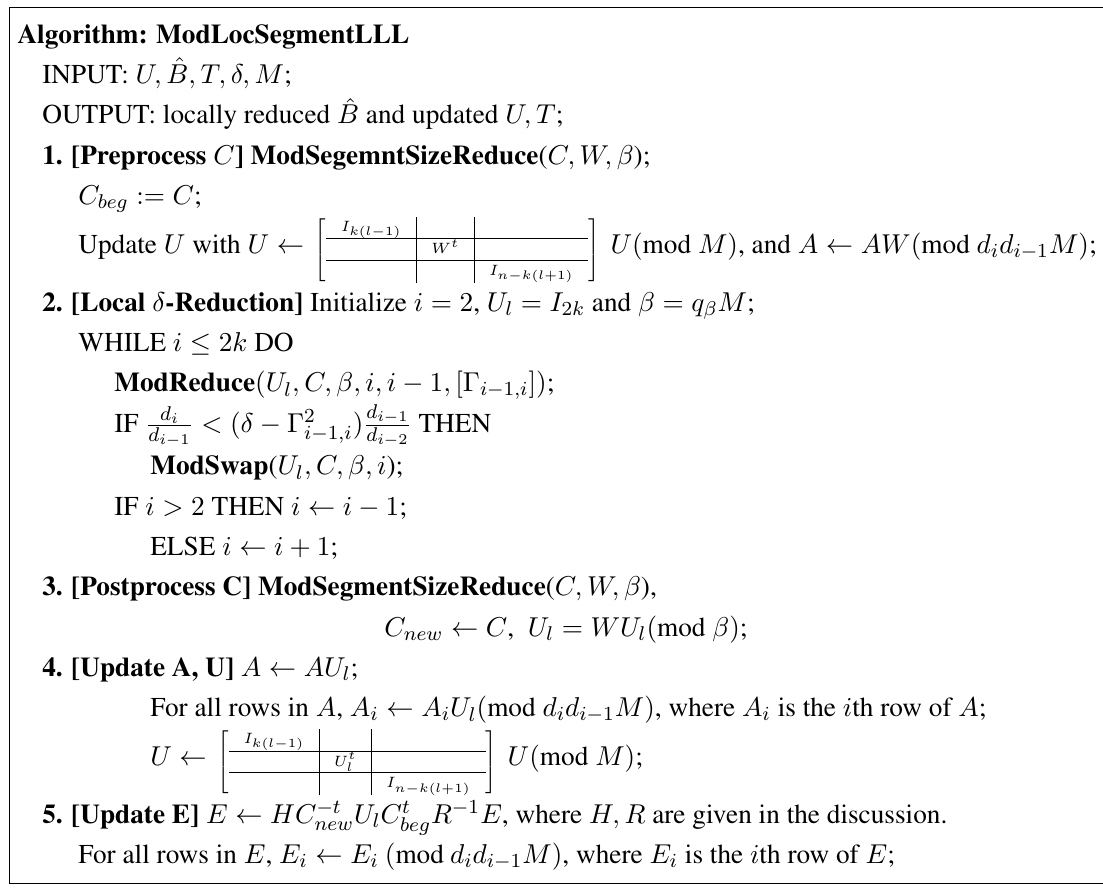
Figure 13. The Modular Local Segment LLL Basis Reduction.